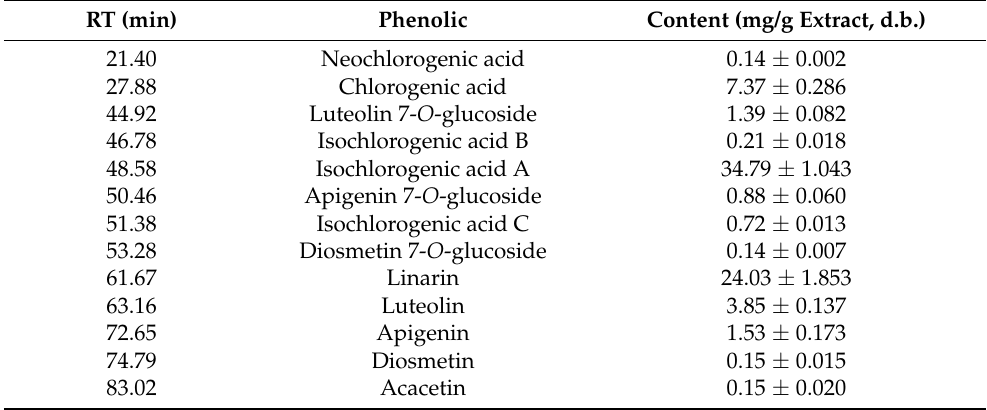
Table 1. Phenolic composition of flower extract of Chrysanthemum boreale (Makino)